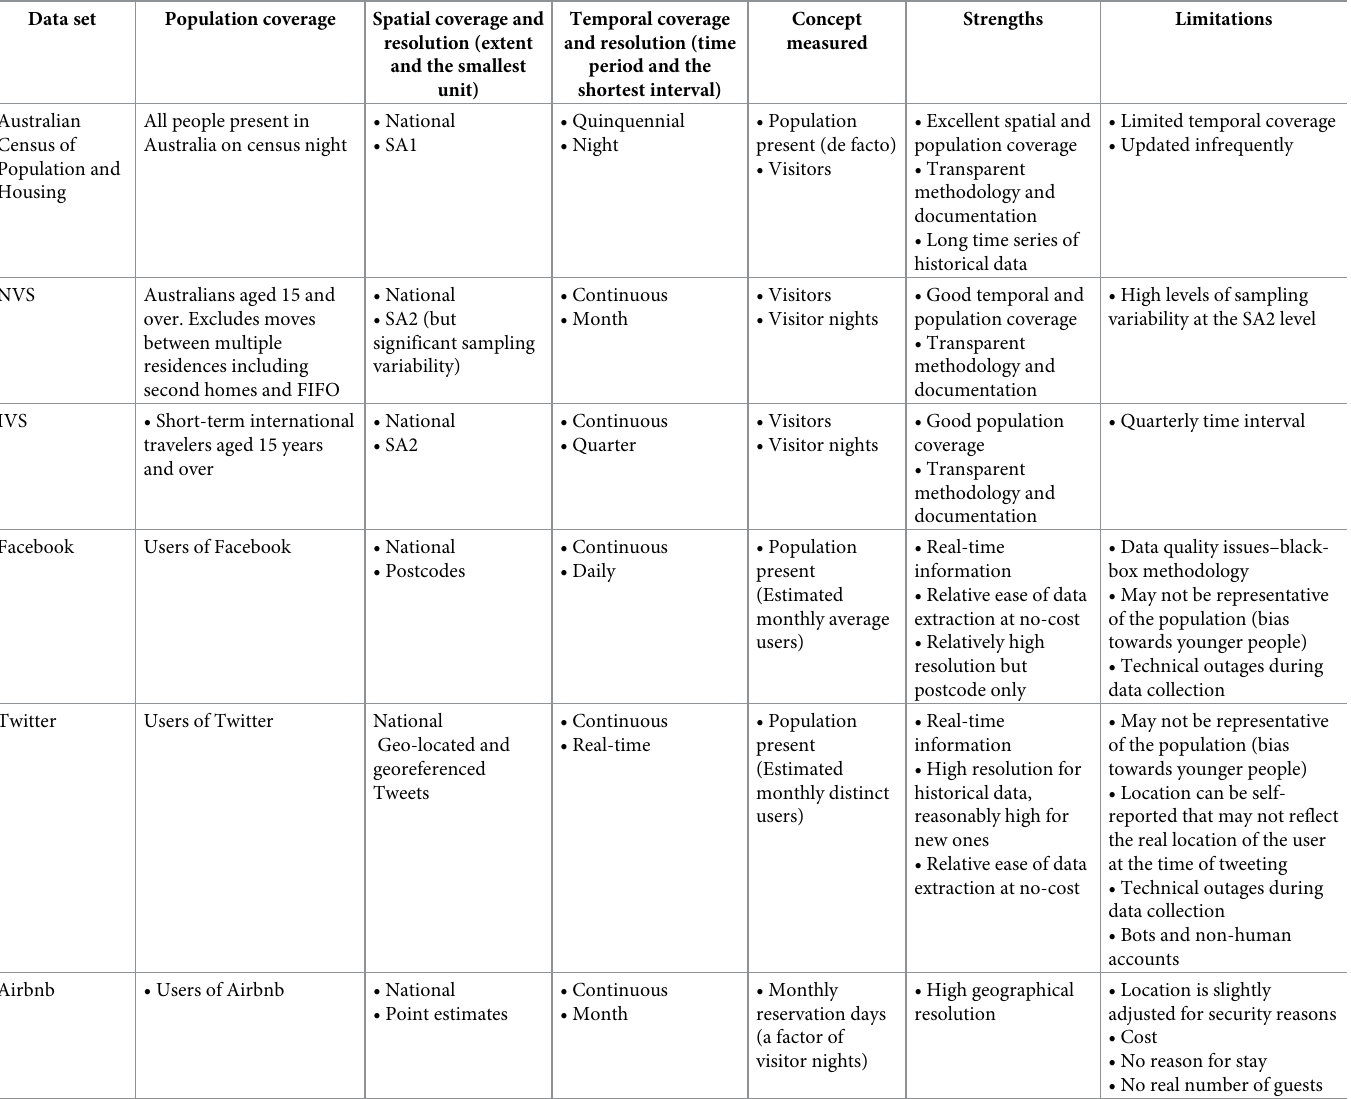
Table 1. Summary of candidate data